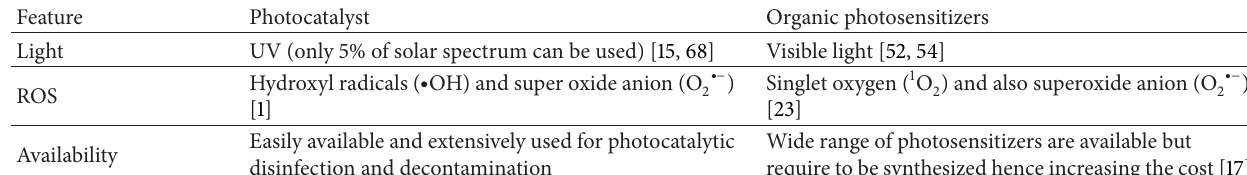
Table 3: Comparison of features of photosensitizers and